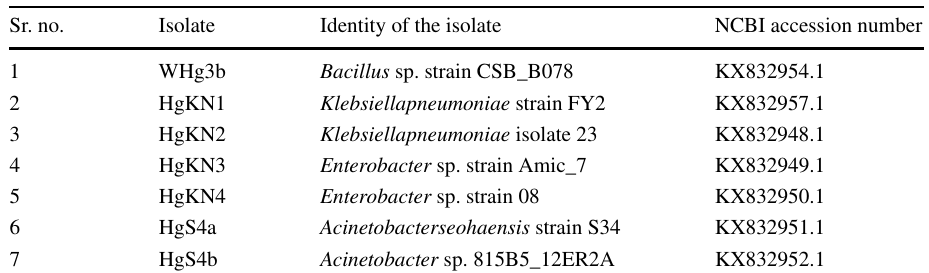
Table 5 Identification of the mercury-resistant isolated bacteria